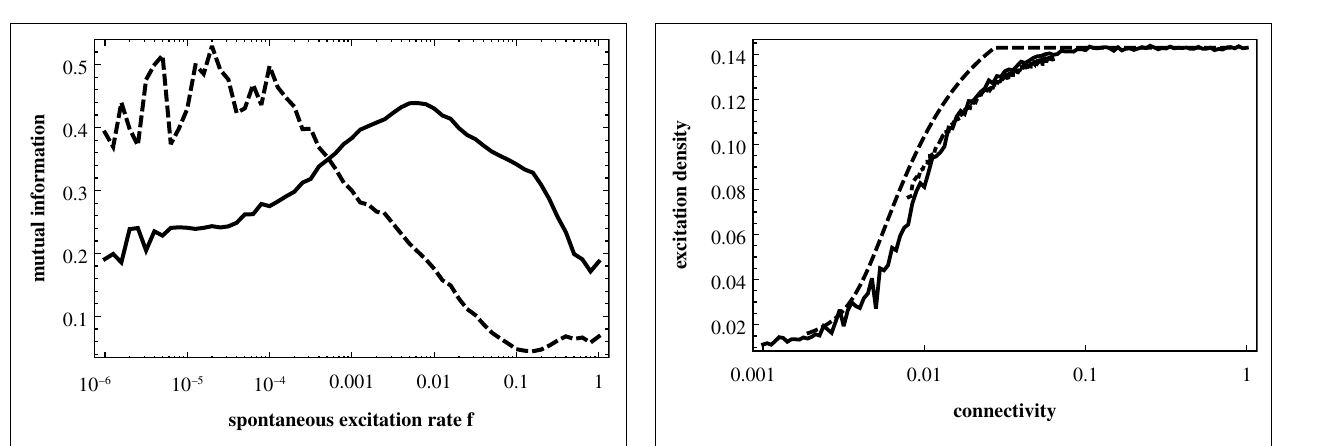
FIGURE 4 | Same as Figure 3B, but for N = 1024. The full curve shows the mutual information obtained from the similarity matrix C ( f ) and the matrix T ; the dashed curve is the mutual information for C ( f ) and D .